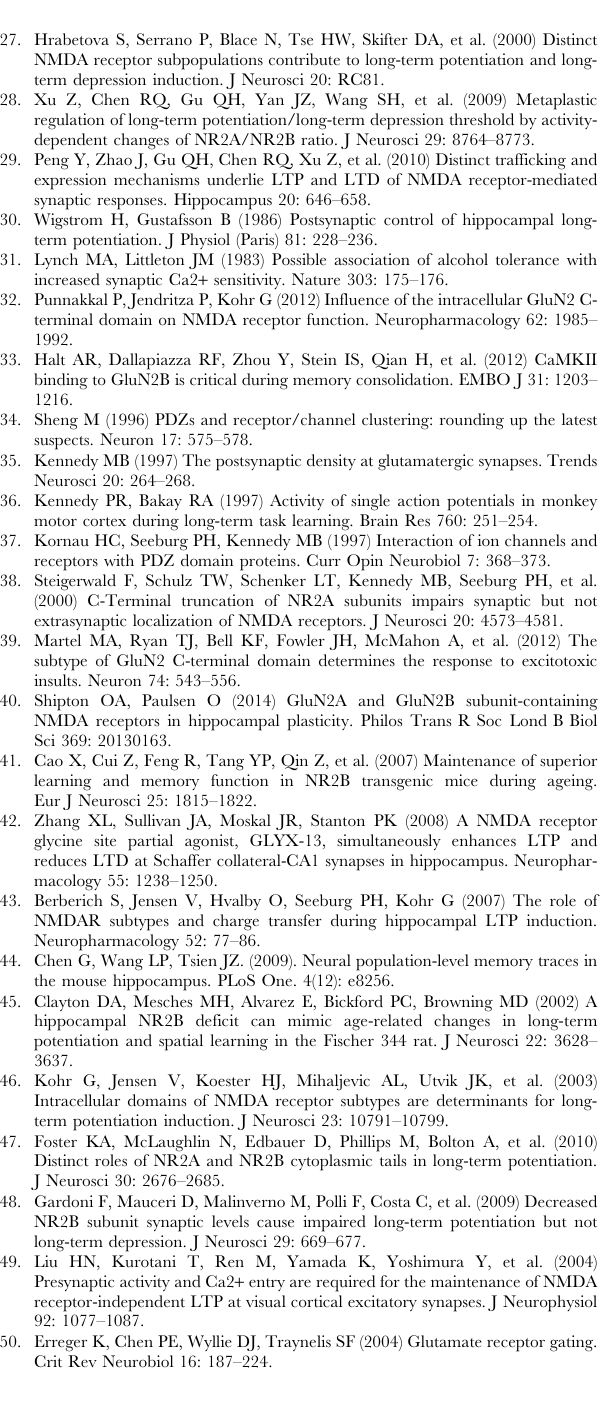
Figure S2 Electrophysiology of hippocampal slices. ( A ) There were no significant differences in the basal synaptic transmission as seen in the CA3-CA1 input-output curve between the wildtype mice and the transgenic mice. ( B ). The paired-pulse facilitation was unchanged between the wildtype and the chimeric transgenic mice indicating that the presynaptic function is